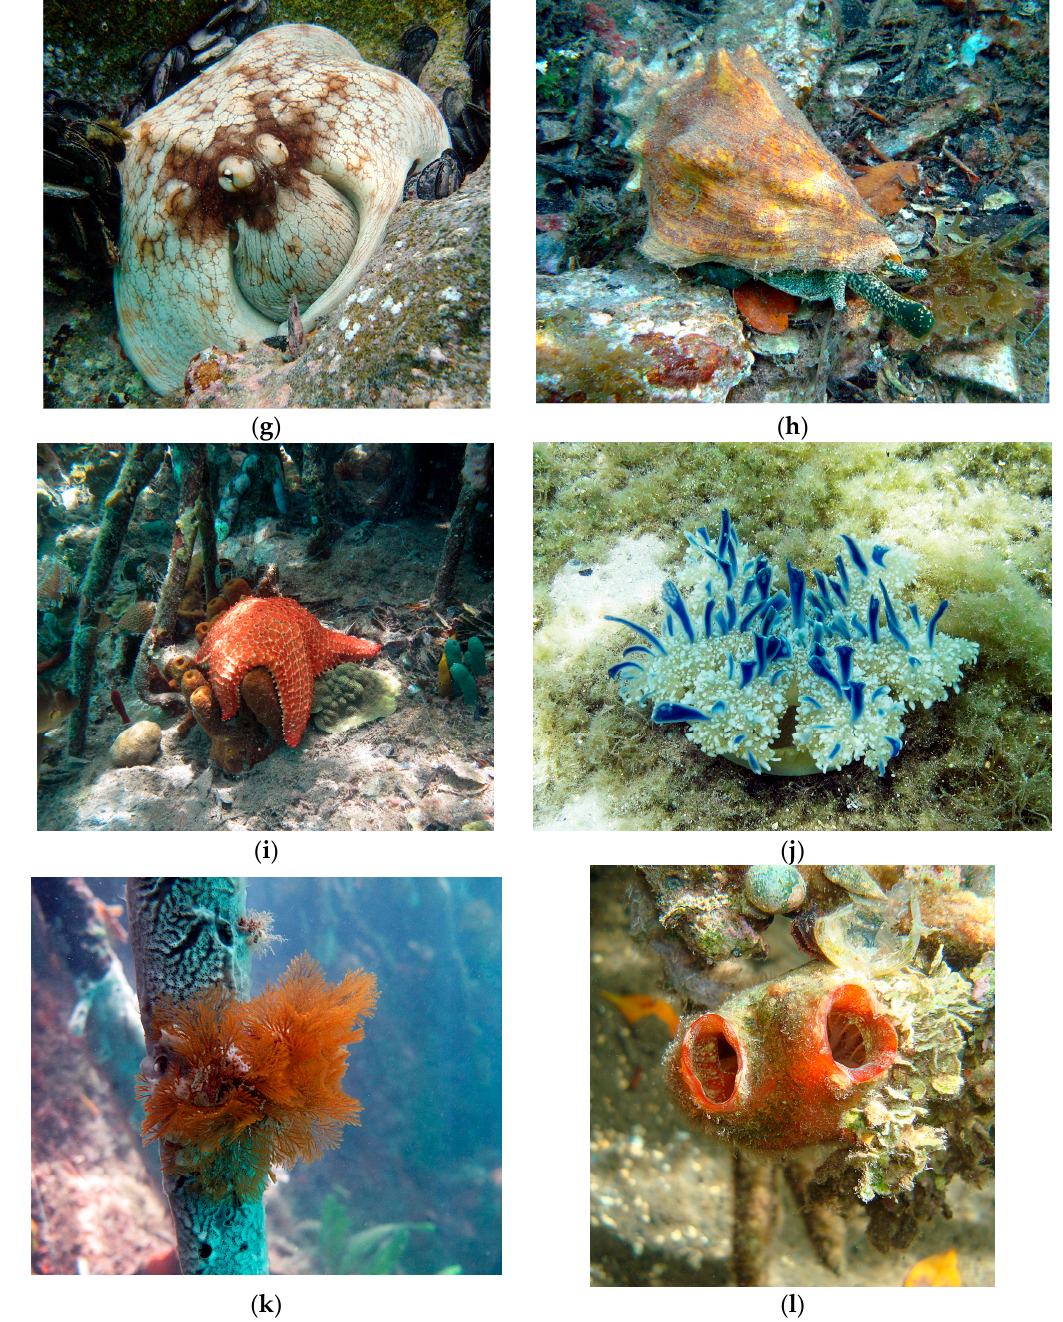
Figure 10. ( a ) Banded Coral Shrimp ( Stenopus hispidus ); ( b ) Spiny lobster ( Panulirus argus ); ( c ) Channel clinging crab ( Damithrax spinosissimus ); ( d ) Giant Caribbean Anemone ( Condylactis gigantea ); ( e ) Giant Caribbean Anemone ( Condylactis gigantea ); ( f ) Beaded Anemone ( Epicystis crucifer ); ( g ) Common Octopus ( Octopus vulgaris ); ( h ) Queen Conch ( Lobatus gigas ); ( i ) Cushion Star ( Oreaster reticulatus ); ( j ) Upside Down Jellyfish ( Cassiopea sp.); ( k ) Bryozoan; ( l ) Tunicate.